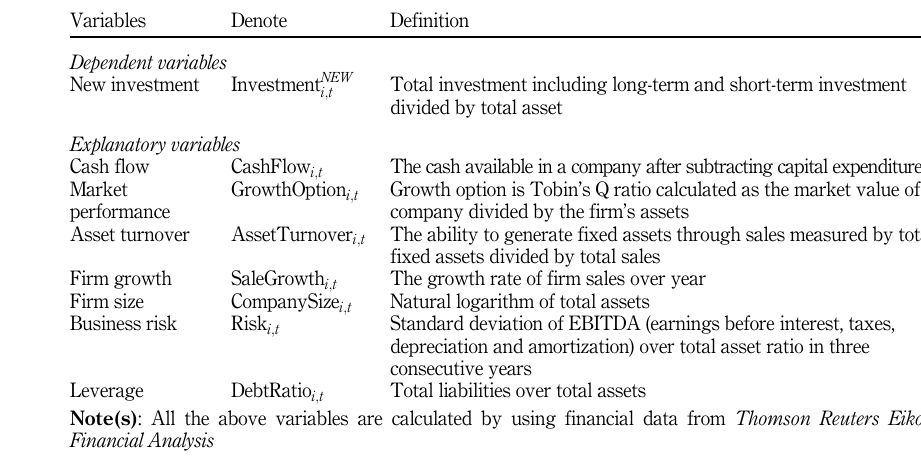
Table A2. Overinvestment